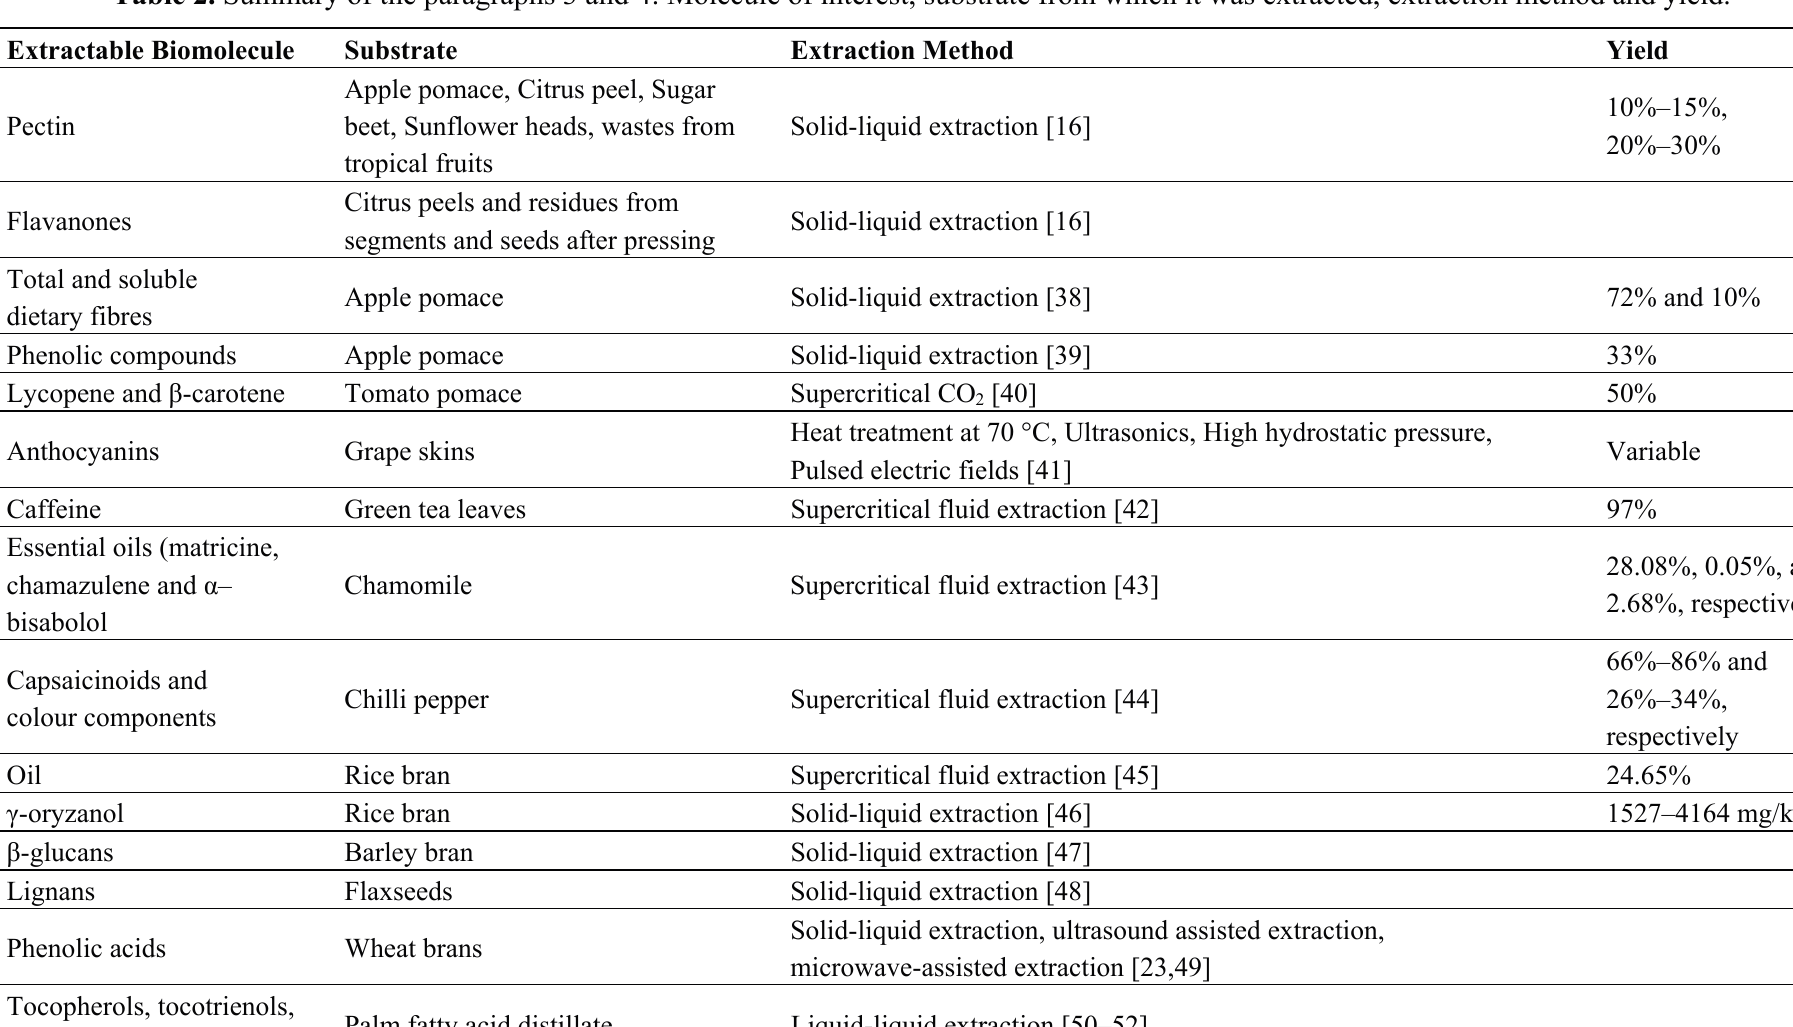
Table 2. Summary of the paragraphs 3 and 4: Molecule of interest, substrate from which it was extracted, extraction method and